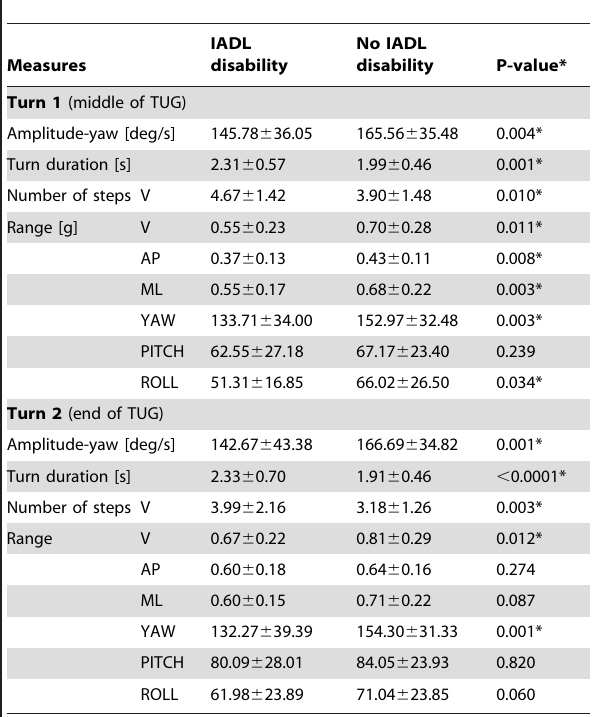
Table 3. TUG signal derived measures of turning during the two turns in subjects with and without IADL